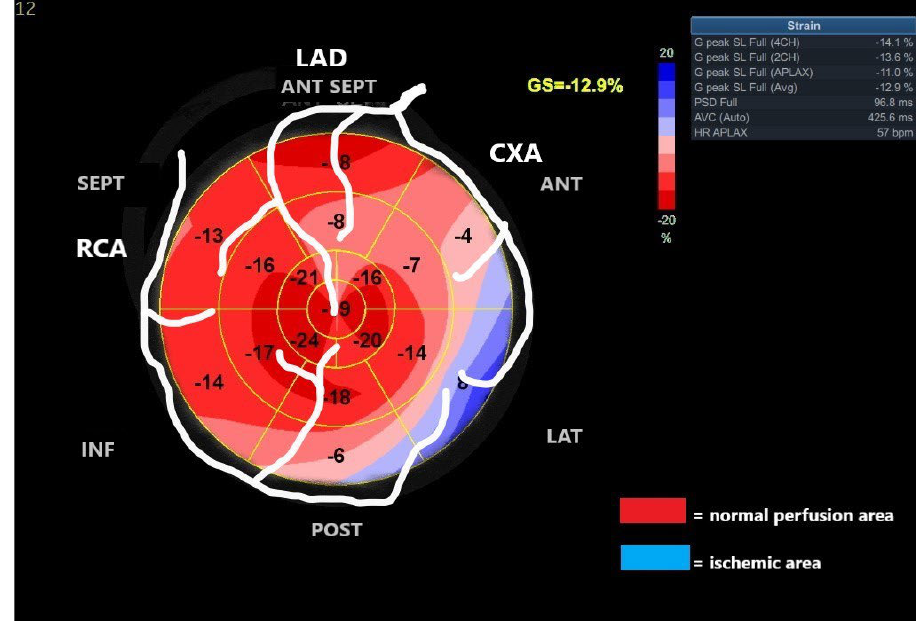
Figure 4. The Bull’s-eye polar map representation of regional global longitudinal strain based on a 17-segment model of distinct coronary artery vascularization areas.